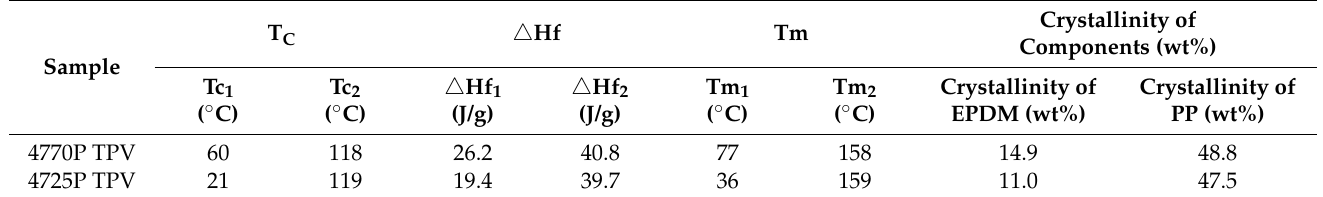
Table 4. Crystallization temperatures, enthalpy of fusion, crystallinities, and melting points of 4770 TPV and 4725